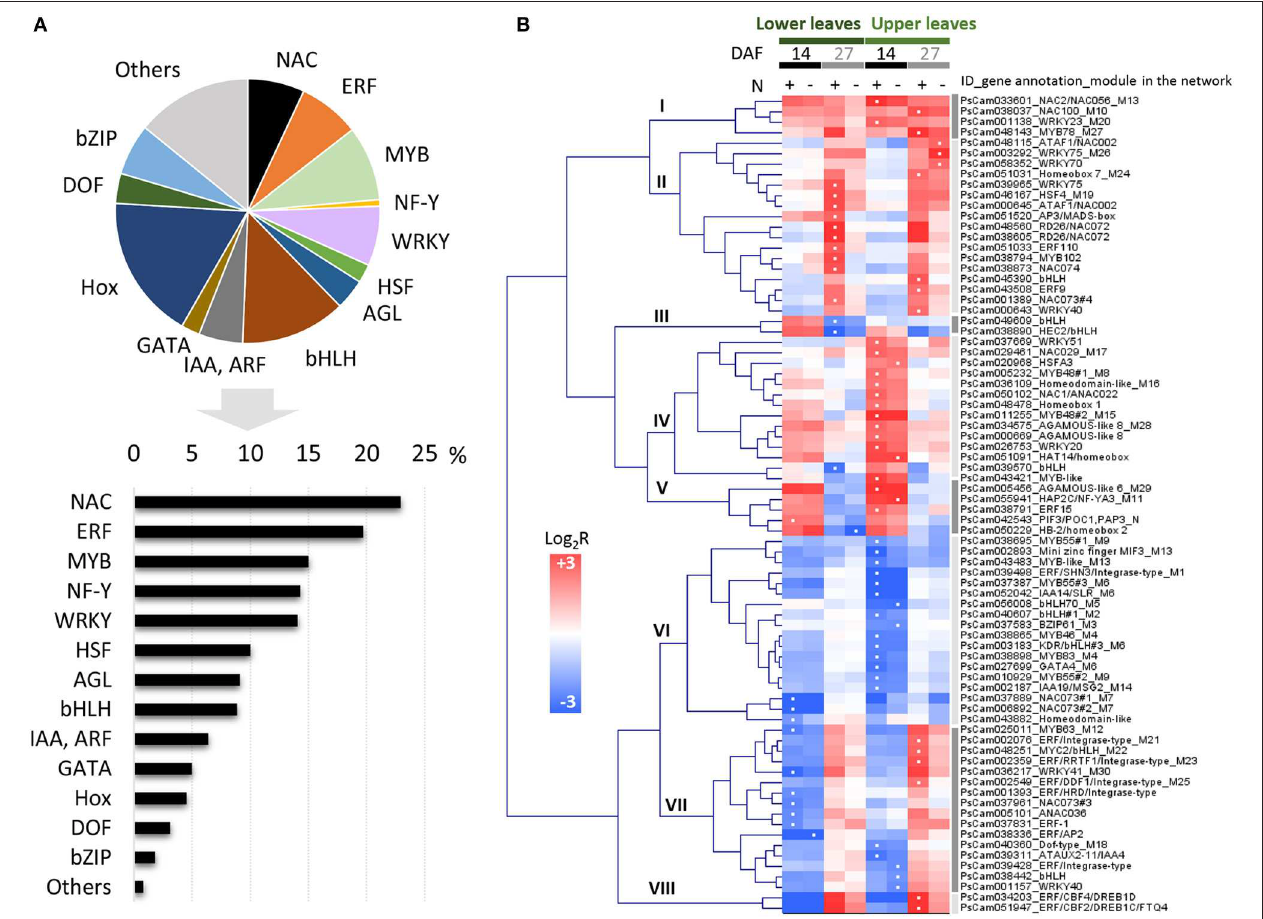
FIGURE 4 | Genes with GO terms related to TF activity (GO:0003700) and regulation of transcription (GO:0045449) differentially expressed at least 4-fold in pea leaves between two developmental stages. (A) Number of differentially expressed genes represented as a percentage (bars) of the total number of genes per TF family (pie chart). (B) Hierarchical clustering of their expression profiles in lower and upper leaves. The color scale indicates Log 2 R for the comparisons 14 DAF vs. flowering (14), 27 DAF vs. 14 DAF (27), and in response to nitrate-deficiency (N–), and white dots in squares indicate the highest values. MYB, myeloblastosis; NF-Y, nuclear factor Y; HSF, heat shock transcription factor; AGL, agamous-like; bHLH, basic helix-loop-helix; IAA, indoleacetic acid-induced protein; ARF, auxin response factor; Hox, Homeodomain/homeobox; DOF, DNA-binding One Zinc Finger; bZIP, Basic Leucine